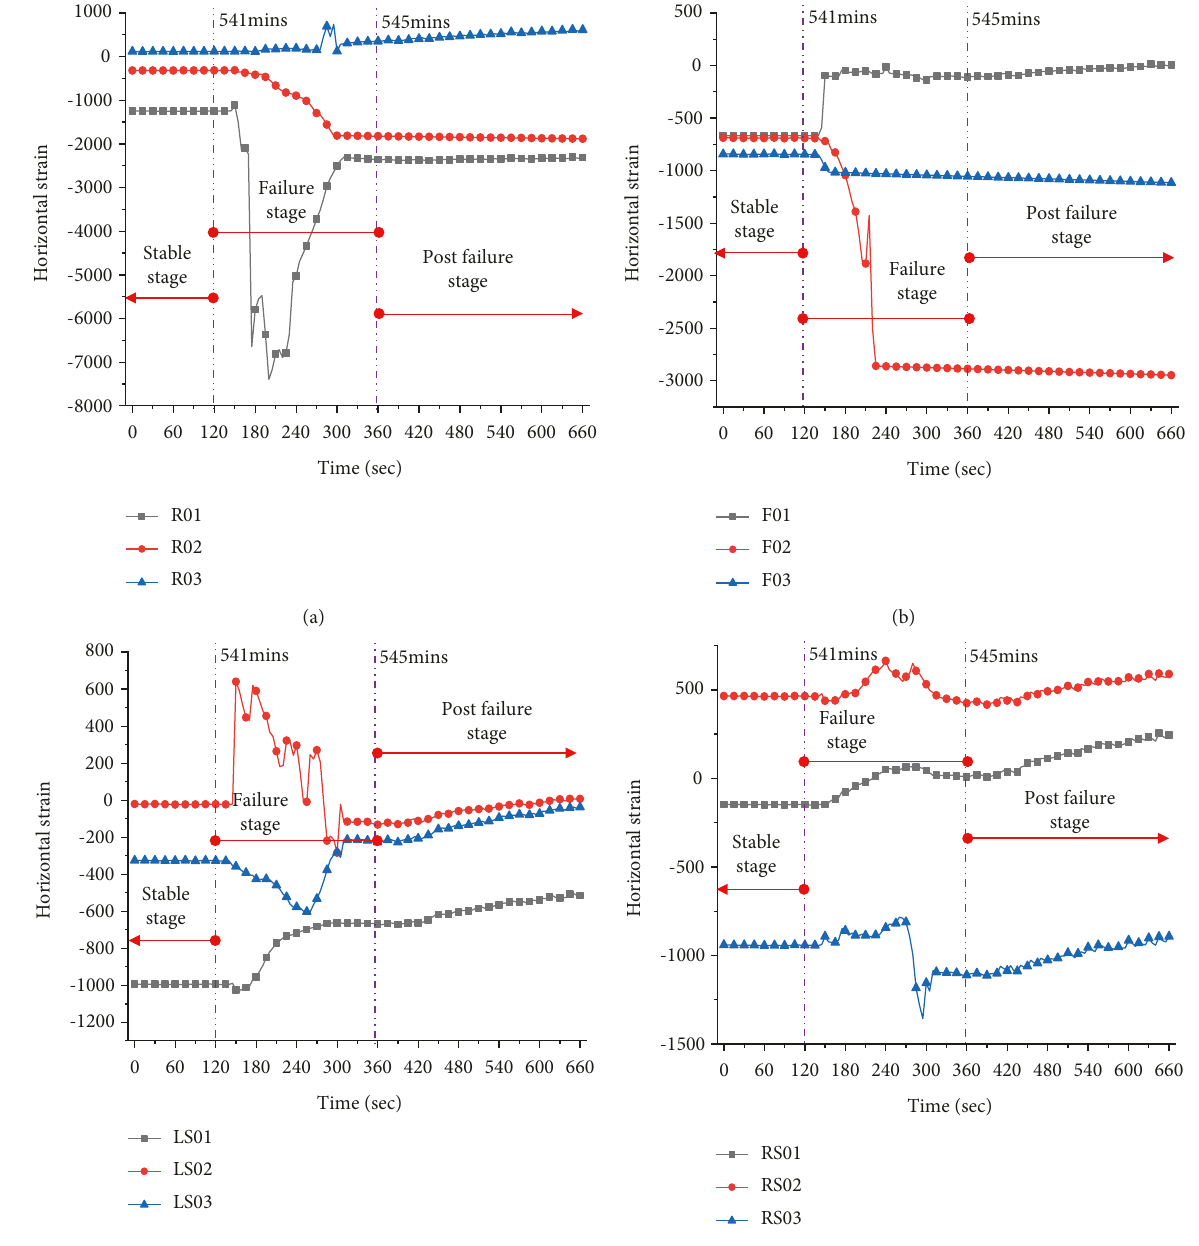
Figure 12: Horizontal strain of measuring points when the cumulative duration is 539 to 550mins; (a) R01, R02, and R03; (b) F01, F02, and F03; (c) LS01, LS02, and LS03; and (d) RS01, RS02, and